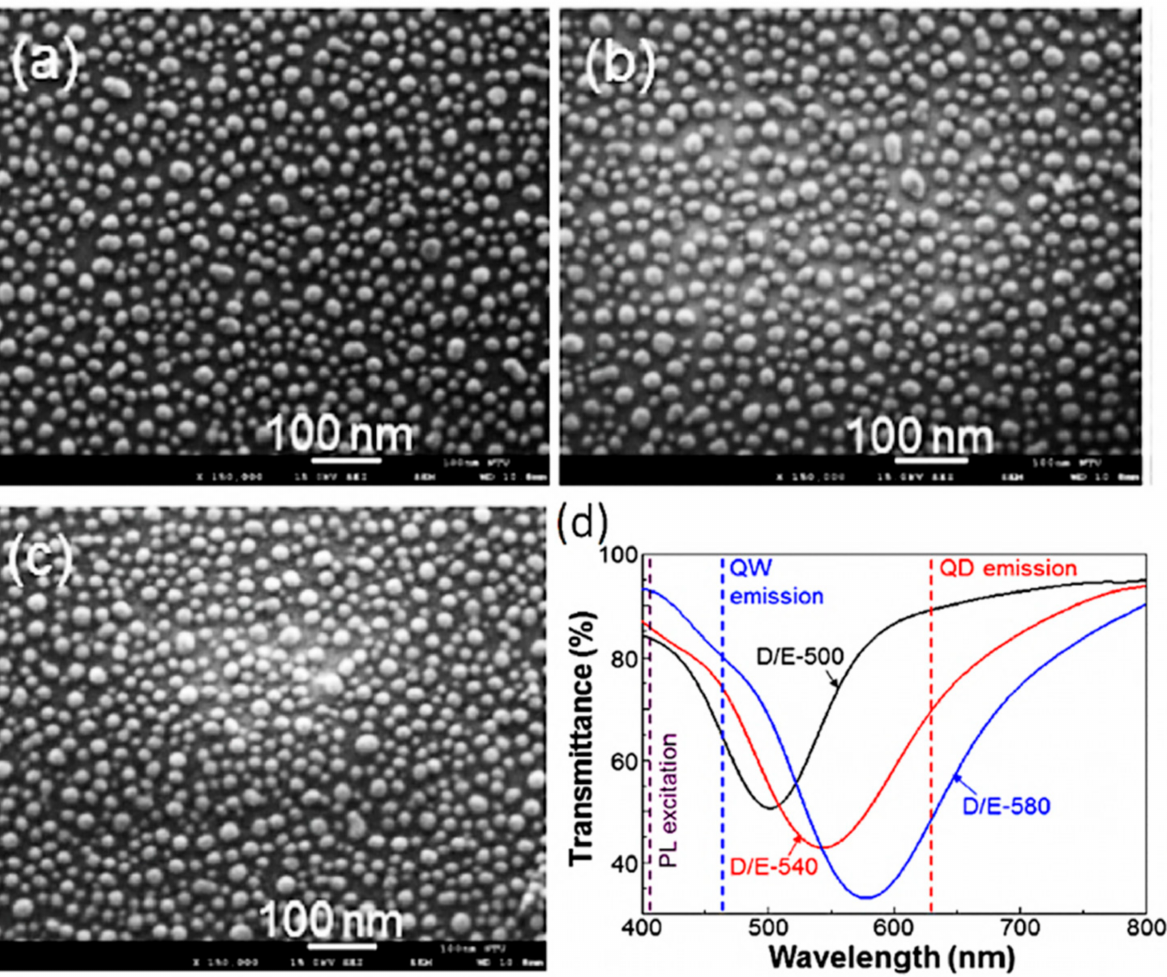
Figure 5. ( a – c ) SEM images of AgNPs for generating LSP resonances with peak wavelengths around 500, 540, and 580 nm, respectively. ( d ) Transmission spectra of the three AgNP structures shown in ( a – c ) illustrating the LSP resonances with peak wavelengths around 500, 540, and 580 nm. Reprinted with permission from [12]. Copyright 2018 The Optical